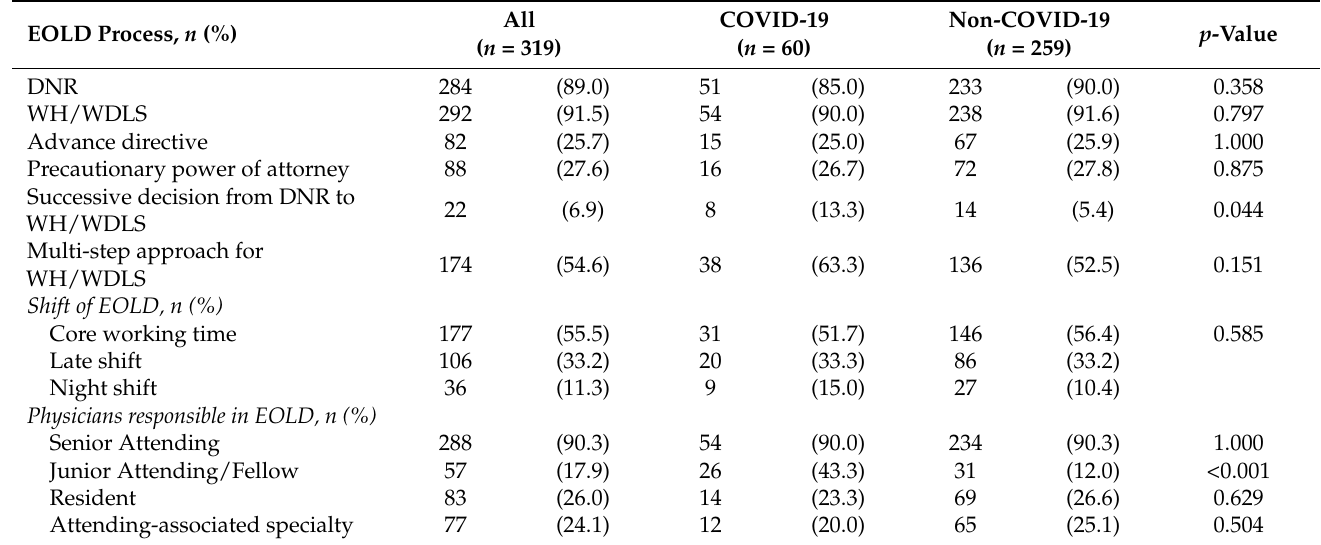
Table 4. EOLD process in patients deceased with